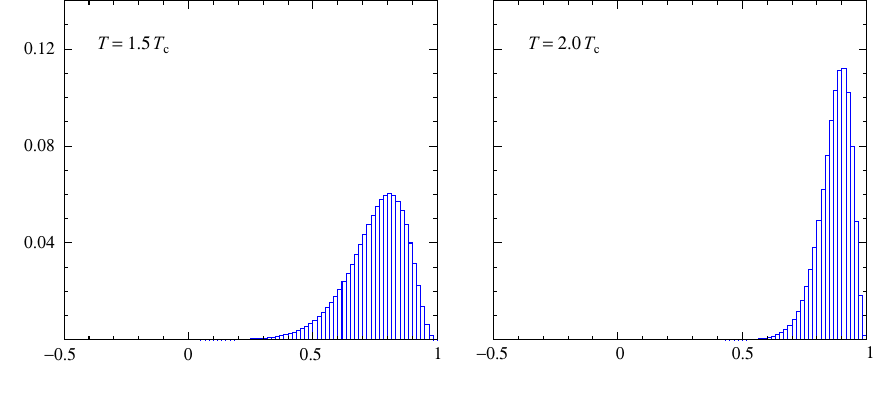
of Re { zP ( x ) } at flow time t = 0 . 35 t 0 measured on the A 1 (left) and B 1 (right) lattices. In both cases, the bin size is 1 / 60 and the phase factor z ∈ { 1 , exp ( ± i 2 π/ 3 ) } is chosen so as to cancel the phase of the average value of the